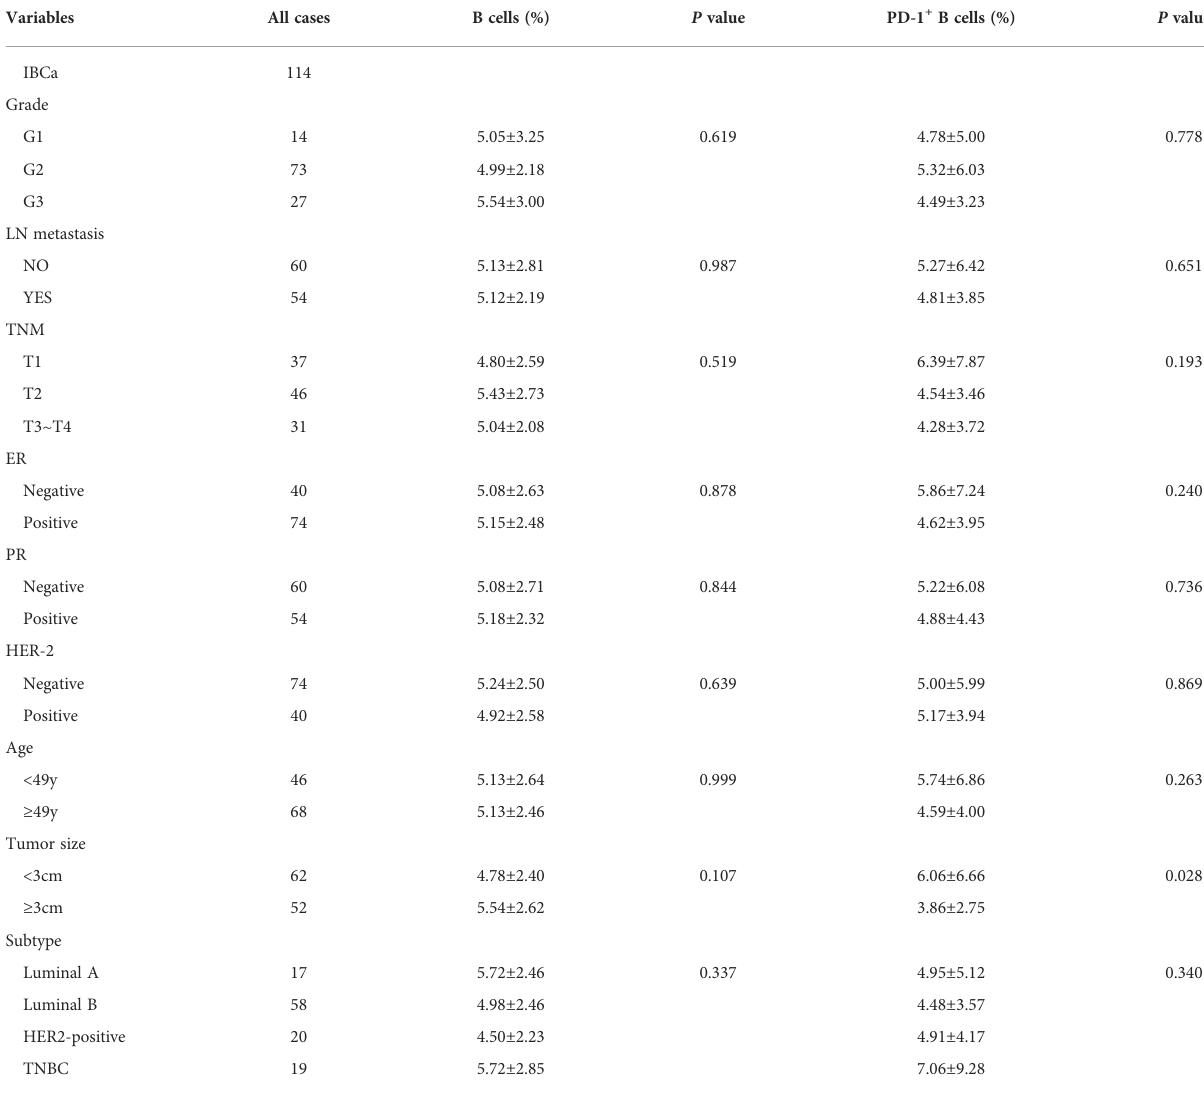
The meaning of “ variables ” is features of invasive breast cancer (IBCa). The meaning of “ All cases ” is the cases of IBCa. The meaning of “ B cells (%) ” is the percentage of CD19+ B cells in the peripheral blood mononuclear cells (PBMCs) of IBCa patients. The meaning of “ PD-1+ B cells (%) ” is the percentage of PD-1+ CD19+ B cells in PBMCs of IBCa patients. The meaning of “ P value ” is the results of statistical